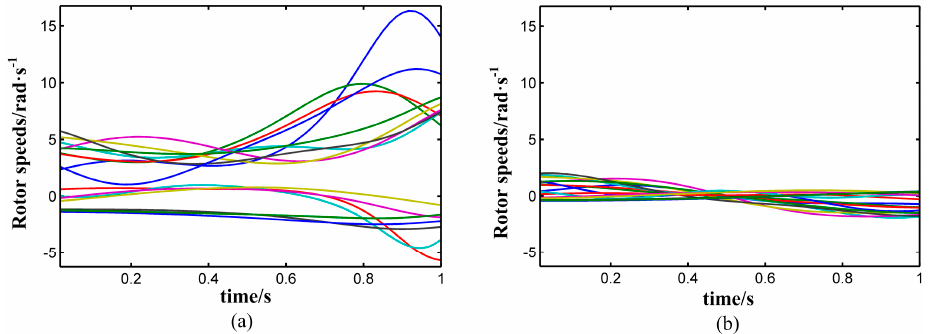
Figure 4. Generator rotor speeds of 16 ‐ machine 68 ‐ bus system: ( a ) unstable case; and ( b ) stable case.